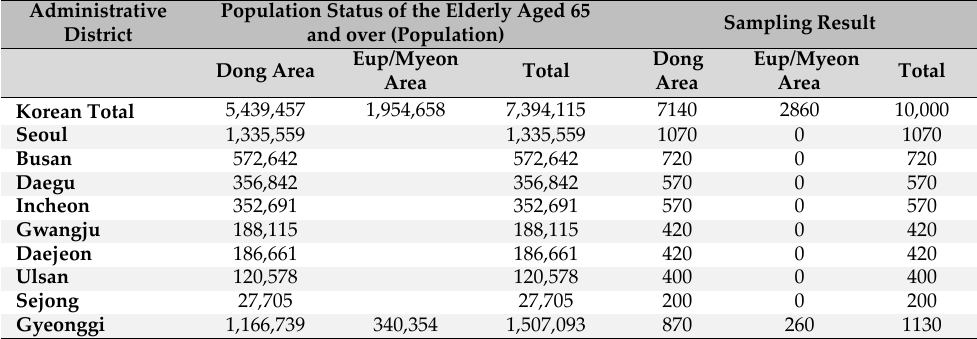
Table 1. Population and Sampling Characteristics of the Korean Elderly